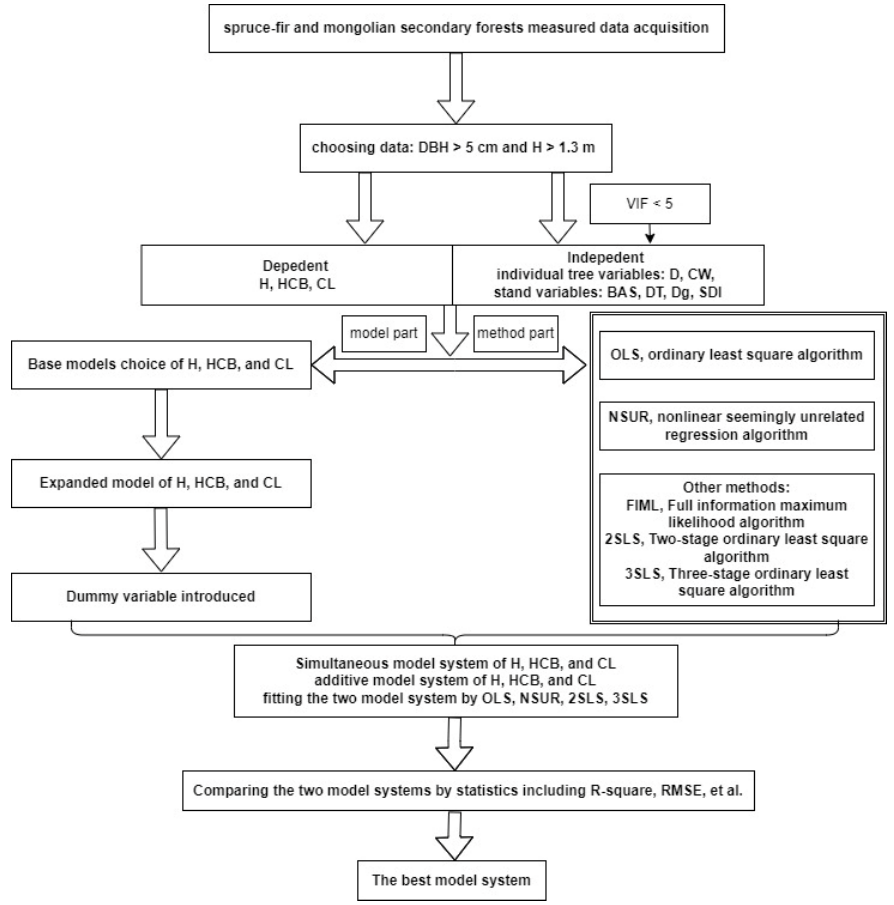
Figure 3. The flow chart of depicting a brief description of the paper.